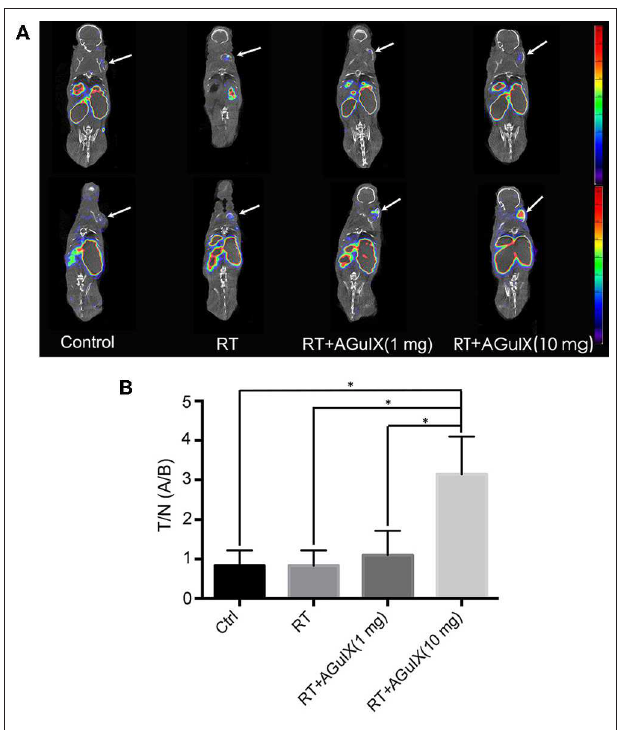
FIGURE 5 | 99m Tc-duramycin SPECT/CT images of the mice in control group and therapy groups before (upper row) and after (below row) radiation. (A) First panel is the control group with no therapy, 99m Tc-duramycin SPECT/CT images and 3 days after 99m Tc-duramycin SPECT/CT images again. In the rest of the panel, 99m Tc-duramycin SPECT/CT images were compared in each panel 1 day before and 1 day after irradiation, and the three panels showed the images of mice injected by tail vein injection of normal saline 1mg of AguIX (third panel) and 10mg of AGuIX (fourth panel), respectively ( n = 3). The same color scale was applied to each of the images. (B) The tumor-to-background ratio (T/B) was used to express tumor signal intensity. Independent-sample t test was used for statistics. The asterisk indicates statistical significance ( P <